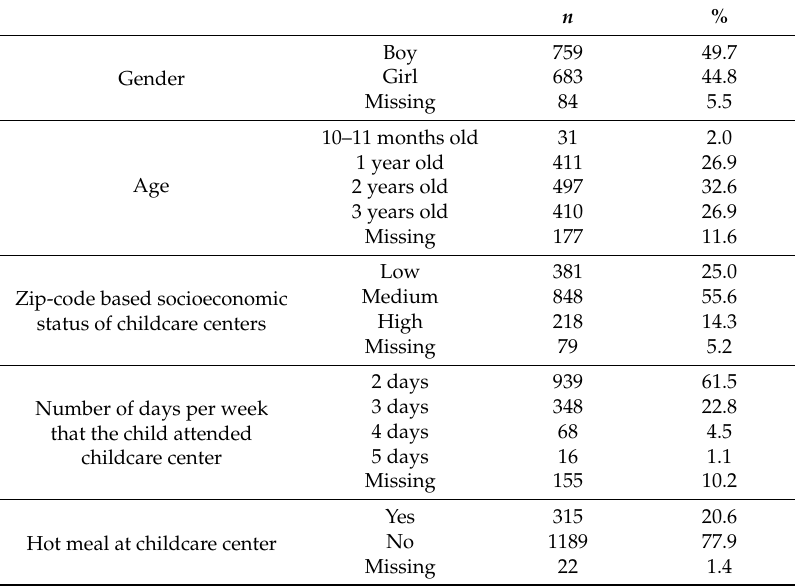
Table 1. Characteristics of the study